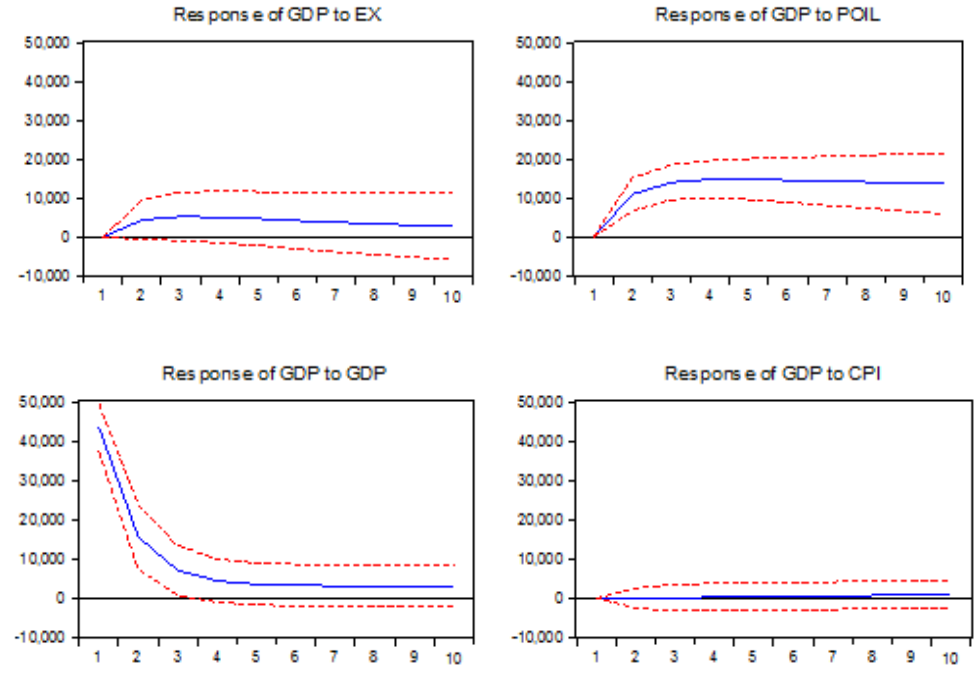
Figure 2. Impulse response functions when shock is applied to